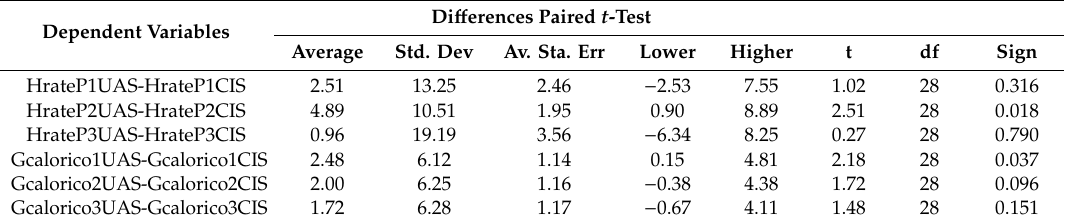
Table 4. t -Test for paired heart rate and caloric expenditure variables according to the scenario (field